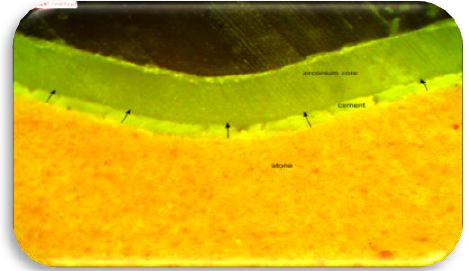
Figure 5: digital image show the border of zirconium core, glass ionmer cement and stone die under the microscope.